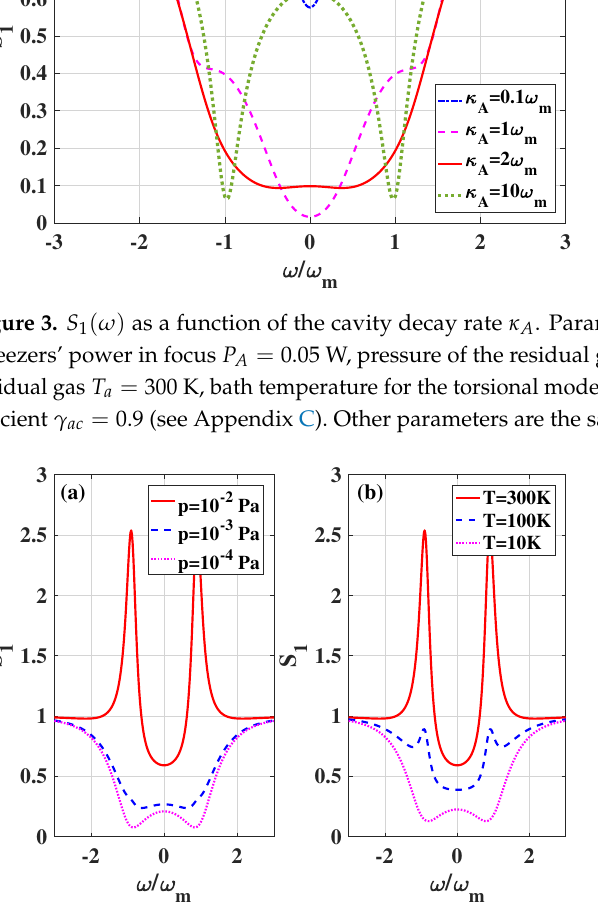
Figure 4. S 1 ( ω ) as a function of the pressure of the surrounding gas p ( a ) and the temperature of torsional mode T ( b ). In pictures ( a ), the temperature of the torsional mode is assumed T = 300 K, while the pressure of residual gas is set to 10 − 2 Pa in picture ( b ). The cavity decay rate is κ A = 3 ω m in both picture ( a ) and ( b ). Other parameters are the same as Figure